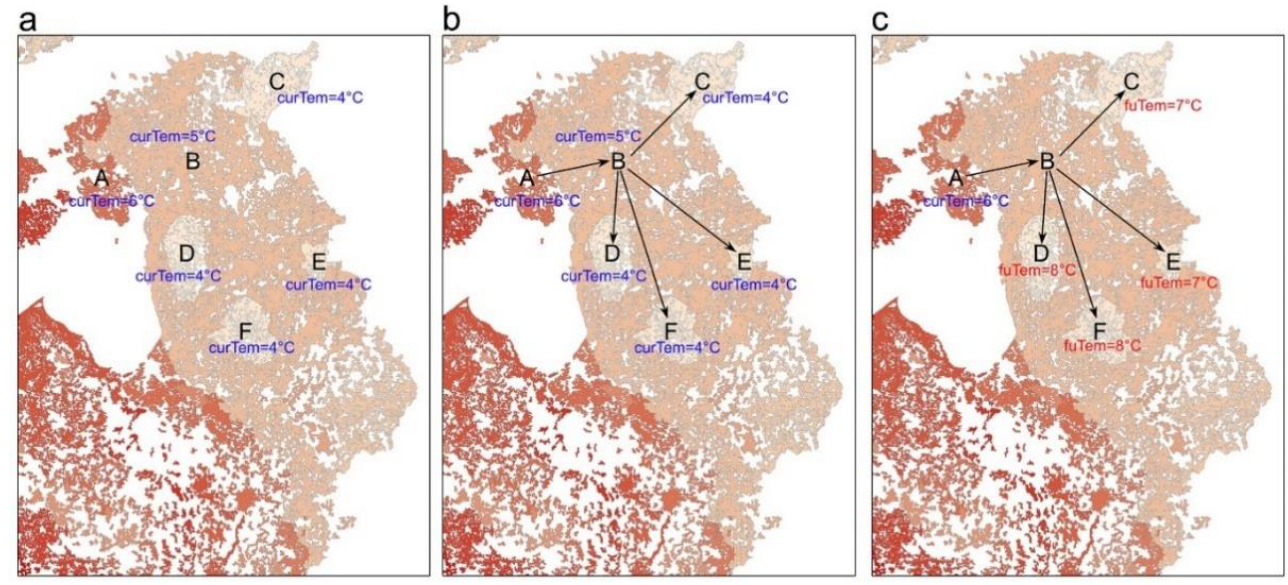
Figure 1. Illustration of our method to assess climate connectivity: ( a ) partitioning patches based on the current temperatures (curTem, in blue) of forest cells; ( b ) building directional paths from hotter to cooler patches; ( c ) the climate connectivity of Patch A ( − 1 ◦ C) was calculated as its current temperature (6 ◦ C) minus the future temperature (fuTem, 7 ◦ C, in red) of its coolest destinations (Patches C and E). Therefore, patches A, B, C, and E were considered stepping stones for range shifts from Patch A to its coolest destinations along temperature gradients.